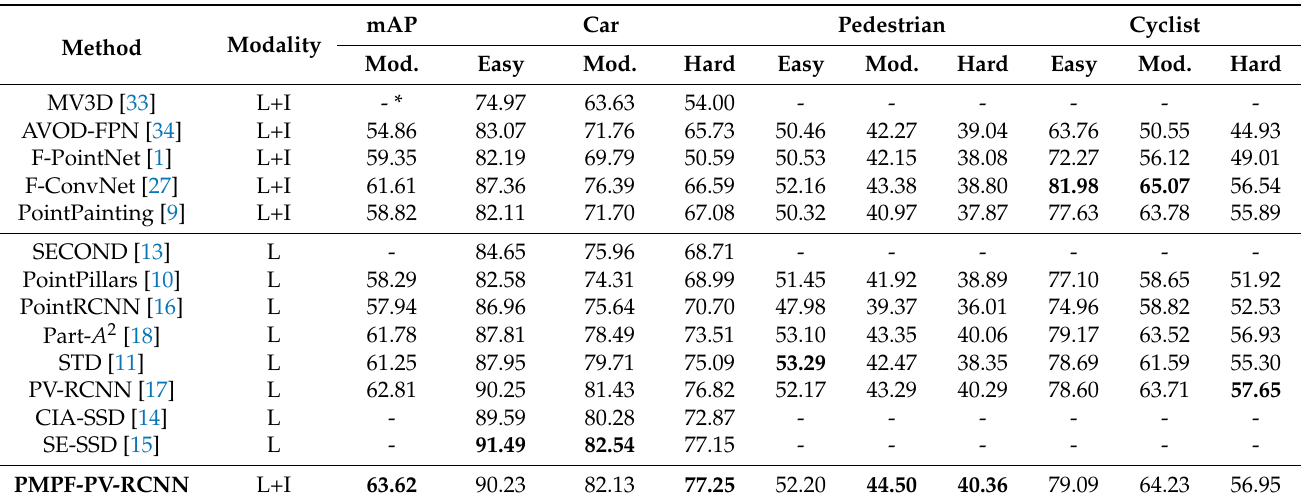
Table 3. Results from the KITTI test set for 3D object detection. These models are LiDAR (L), image (I). Delta is due to the difference in PMPF, i.e., PMPF-PV-RCNN minus